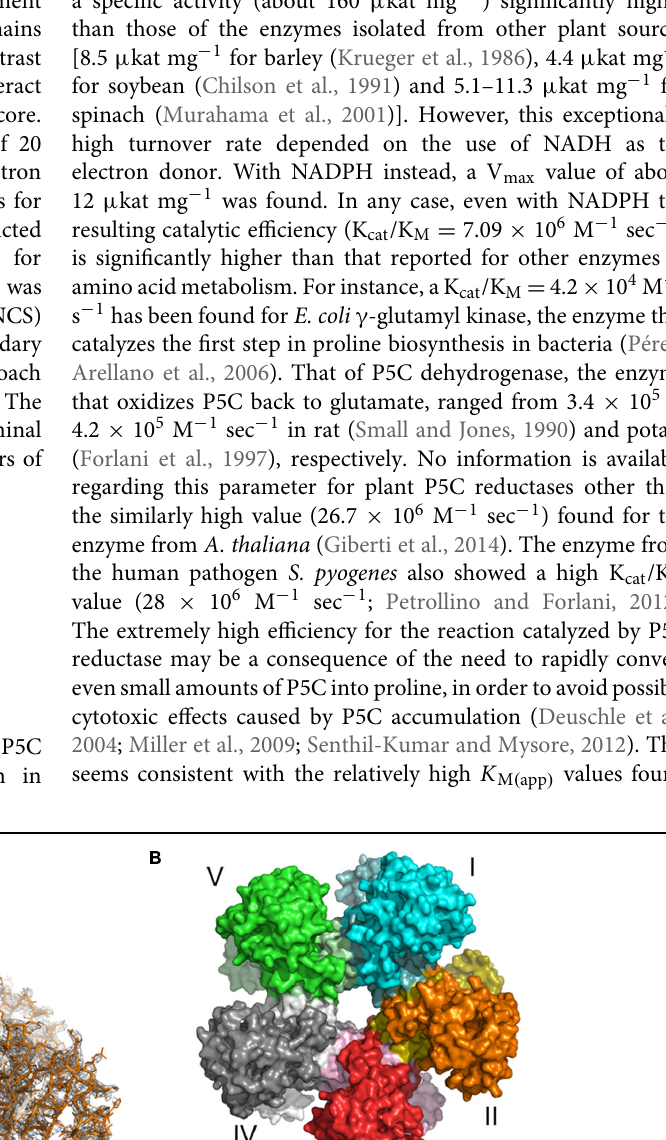
Frontiers in Plant Science |